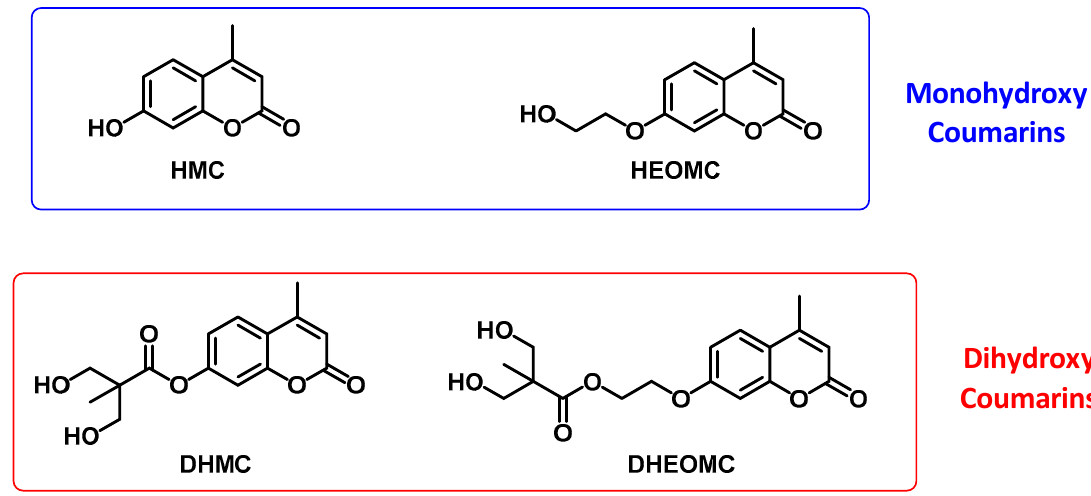
Figure 1. Chemical structures of functionalized coumarins bearing hydroxyl groups .